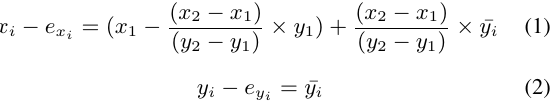
(c) The red circle points out the reconsidered measurements in successive sliding windows.